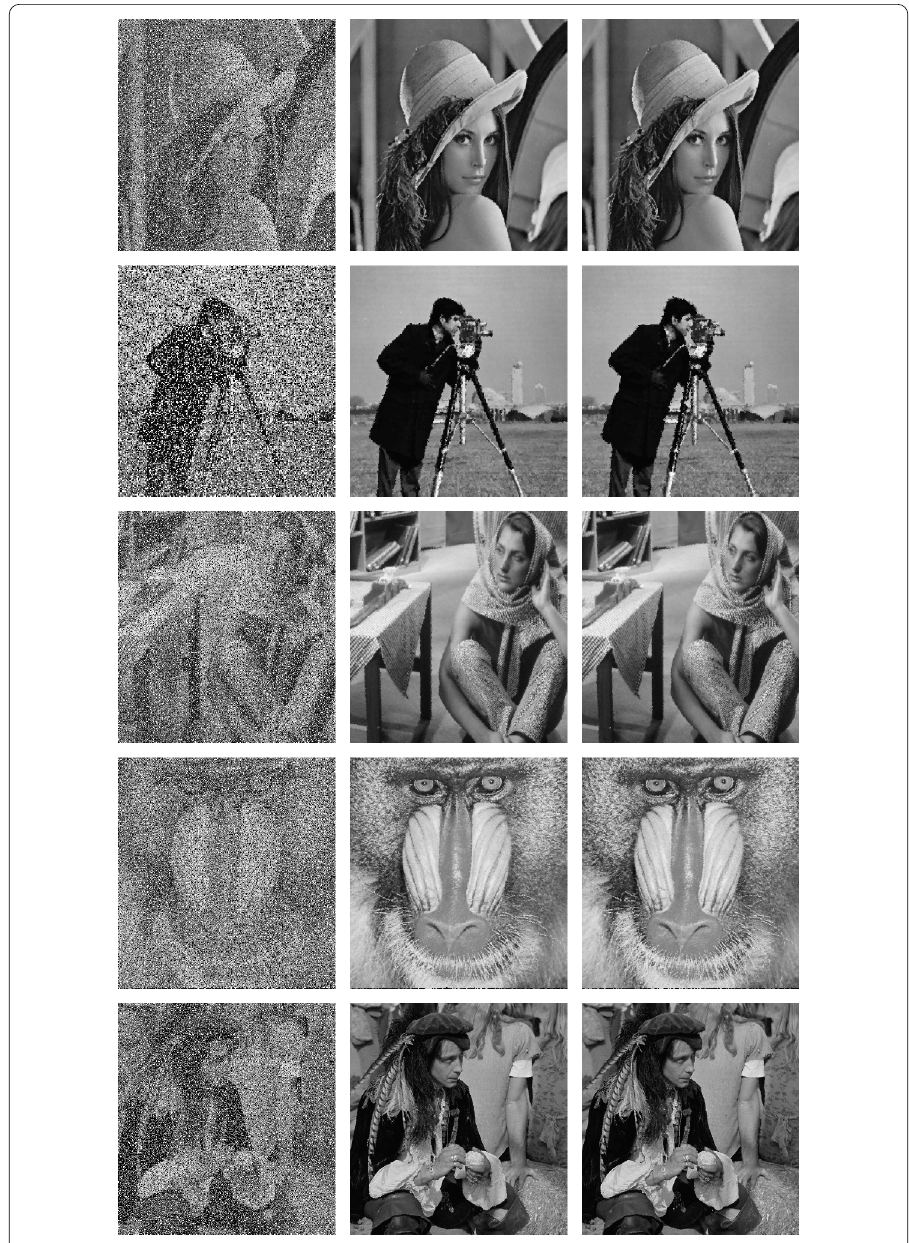
Figure 8 Restoration of the images Lena, Cameraman, Barbara, Banoon, and Man by PRP algorithm and Algorithm 3.1. From left to right: the noisy image with 50% salt-and-pepper noise, the restorations obtained by minimizing z with PRP algorithm and Algorithm 3.1,